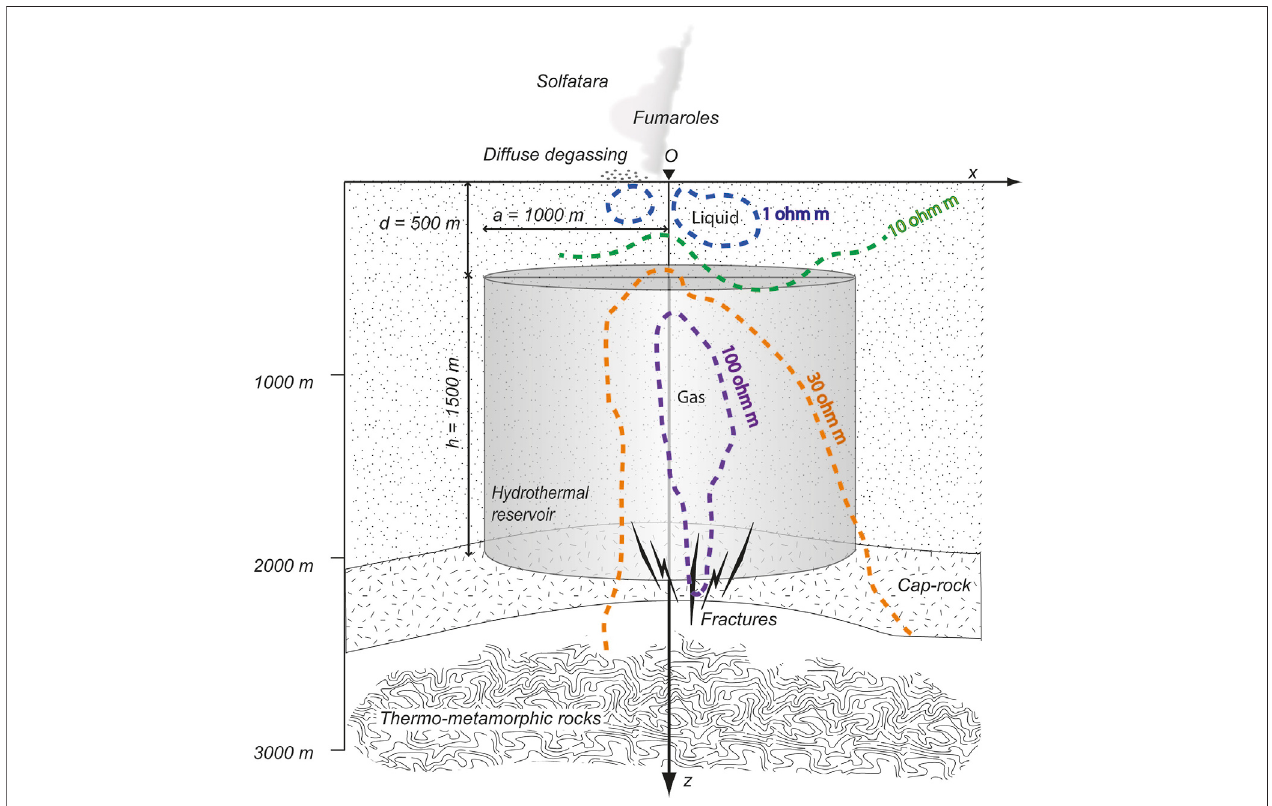
FIGURE 4 | Conceptual model for Campi Flegrei. A shallow, gas-dominated hydrothermal reservoir is identi fi ed by magnetotelluric data (Siniscalchi et al., 2019), above a caprock revealed by seismic data (Vanorio and Kanitpanyacharoen, 2015; Calò and Tramelli, 2018; Akande et al., 2019). Dashed lines refer to resistivity measurements and are redrawn after Siniscalchi et al. (2019). Ground deformation measured at the surface (at the origin point O) is used tocompute the corresponding changes in pore pressure and fl uid content in the reservoir.